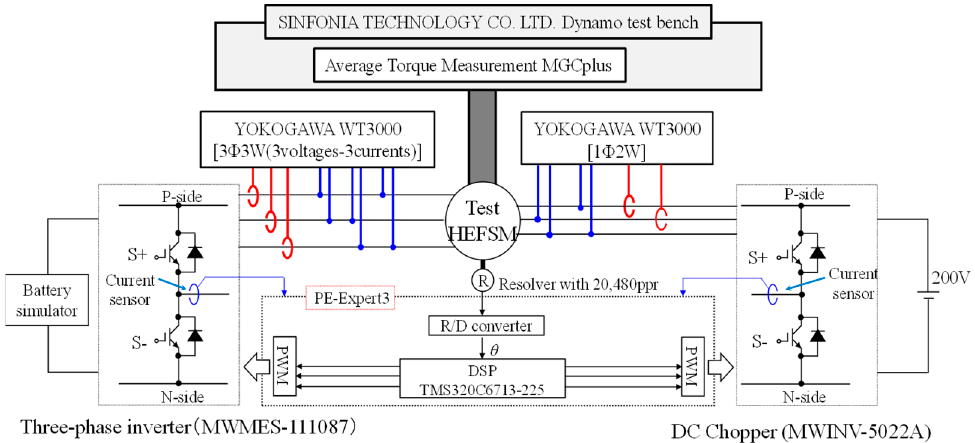
Figure 9. Experimental setup for efficiency measurement under normal operation. ©2020 IEEE. Reprinted with permission, from K. Otsuka, T. Okada, T. Mifune, H. Matsumori, T. Kosaka and N.